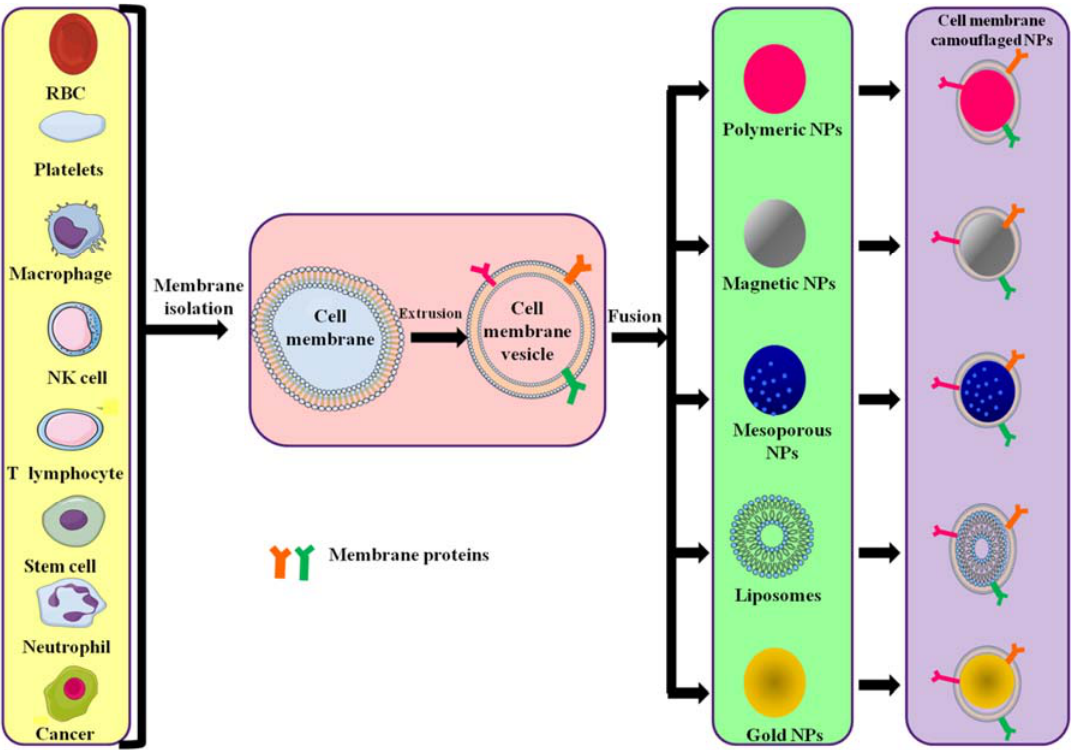
Figure 2. Different source cells and types of polymeric NPs formed by camouflaging different membranes. Cell membranes are isolated from their source cells and extruded to obtain membrane vesicles. The vesicles then fuse with core NPs to form membrane ‐ camouflaged nanoparticles.